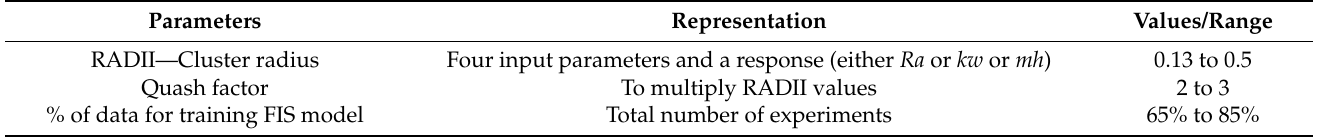
Table 3. FIS parameters used for the investigation.